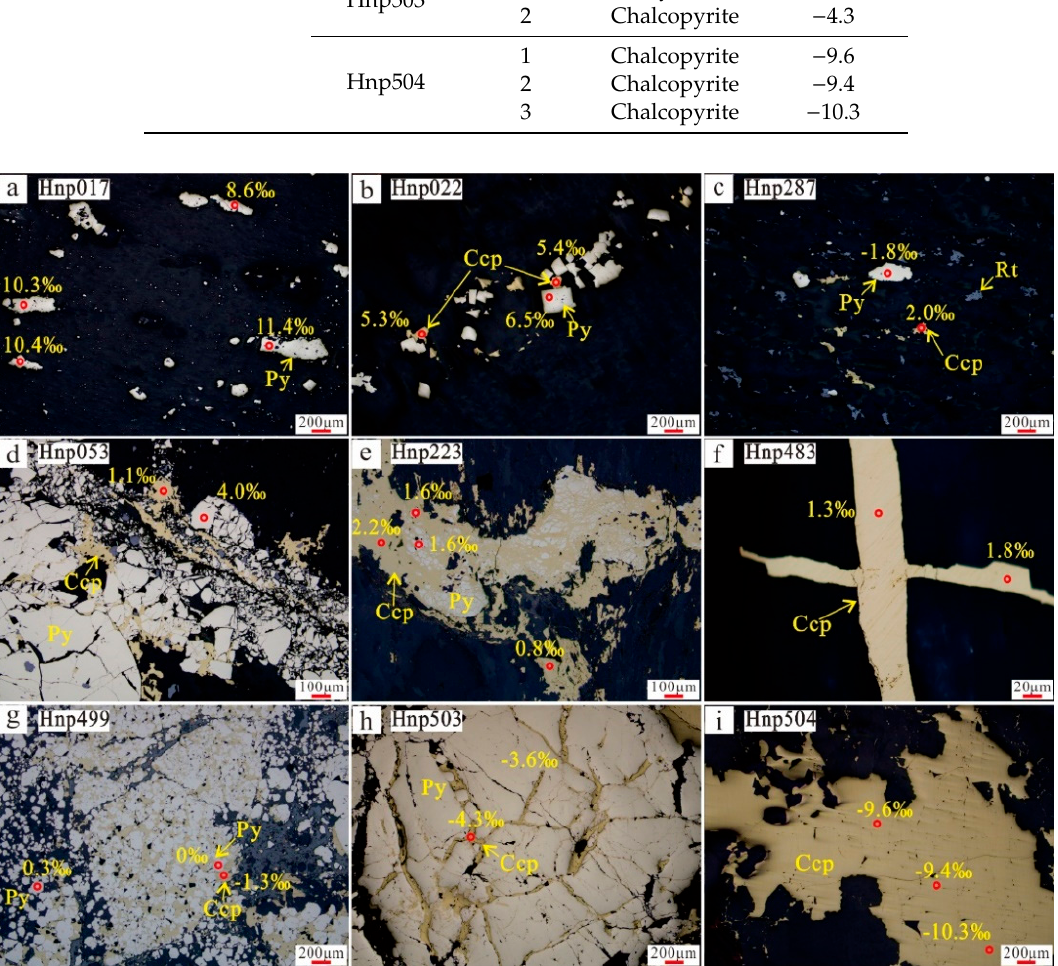
Figure 8. In situ S isotope laser spot locations and corresponding δ 34 S values of sulfides from the abbreviations: Py, pyrite; Ccp, chalcopyrite; Rt,